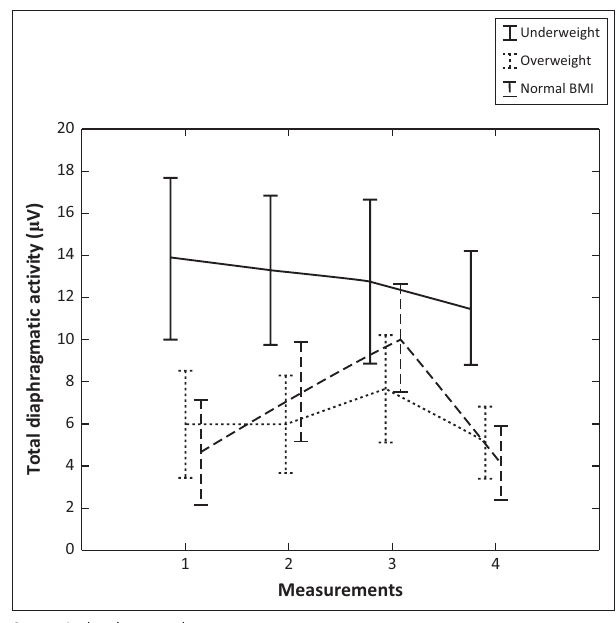
FIGURE 3: Effect of nutritional status on change in total diaphragmatic activity. Points are mean and vertical bars denote 95 % confidence interval, overall effect p = 0.004.